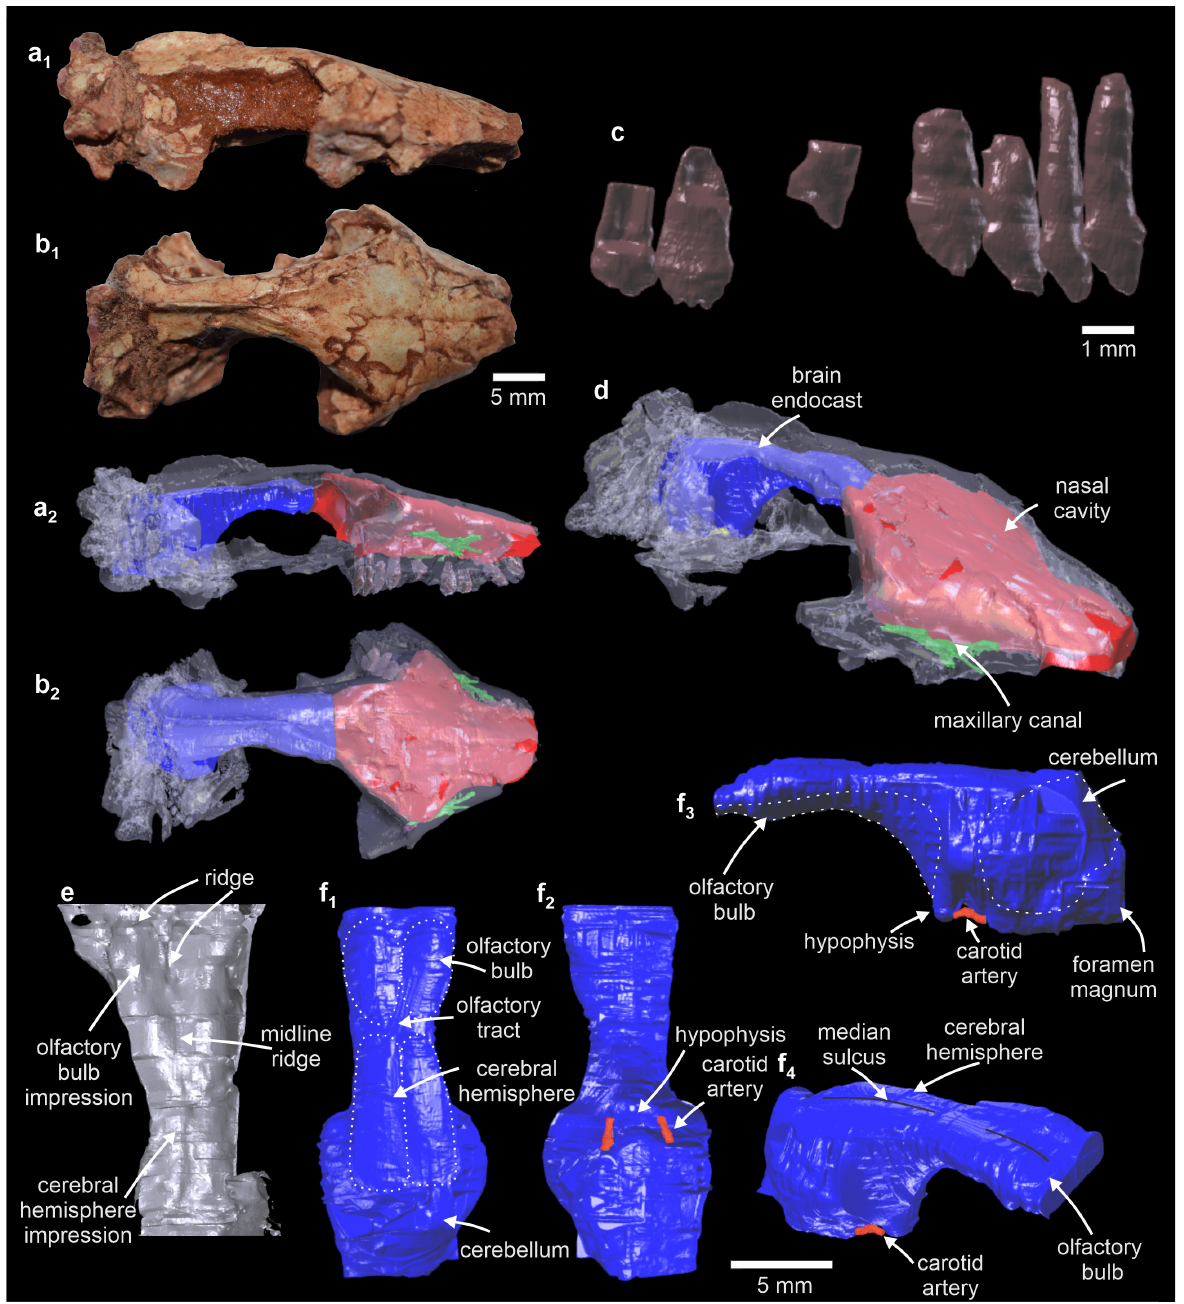
Figure 1. Cranium (MCN-PV 10348) and three-dimensional reconstructions of the endocranial cavities of Riograndia guaibensis from the Upper Triassic of southern Brazil. a and dorsal views, respectively; c, three-dimensional reconstructions of the left postcanines, in labial view; a d, translucent reconstructions of the cranium showing the endocranial cavities in lateral, dorsal, lateral oblique (slightly enlarged relative to the other two views) views, respectively; e, three-dimensional reconstruction of the cranial roof (frontal and parietal) in ventral view; f views, respectively. Dashed areas on the endocast in lateral view (f (ventral region) and areas in which the endocranial surface was not properly preserved to analyze the impression of soft